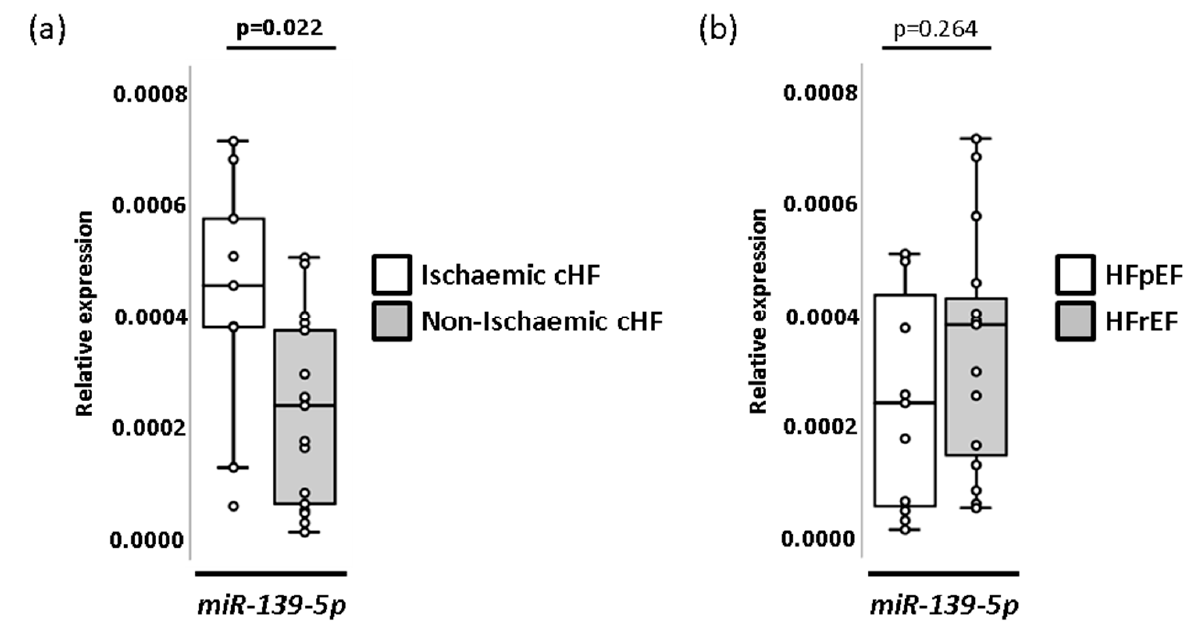
Figure 8. miRNAs patterns associations with cHF underlying aetiology and ejection fraction. ( a ) Box and whisker plots of miRNA miR-139-5p in cHF patients according to underlying aetiology (ischaemic and non-ischaemic). ( b ) Box and whisker plots of miRNA miR-139-5p in cHF patients according to ejection fraction (HFpEF and HFrEF). A p < 0.05 was considered significant. cHF: chronic heart failure; HFpEF: heart failure with preserved ejection fraction; HFrEF: heart failure with reduced ejection